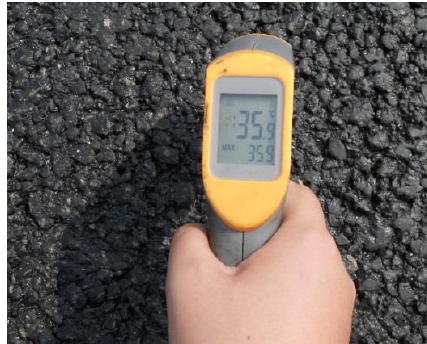
Figure 3. Temperature measurement for the control pavement.